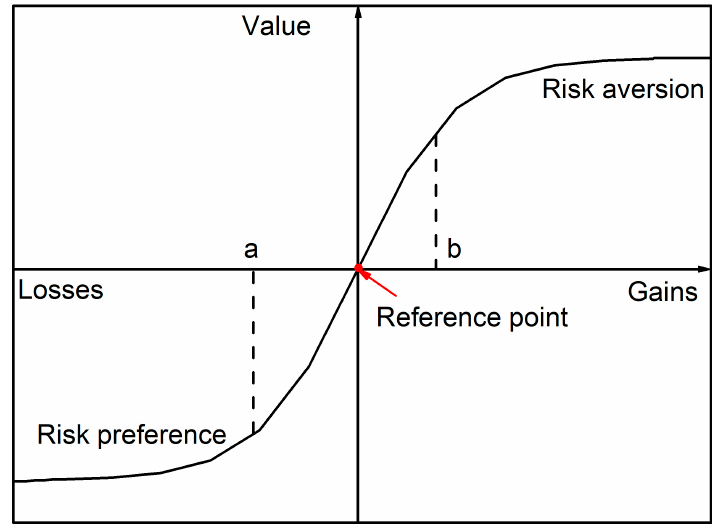
Figure 1. The concept mapping of value function.